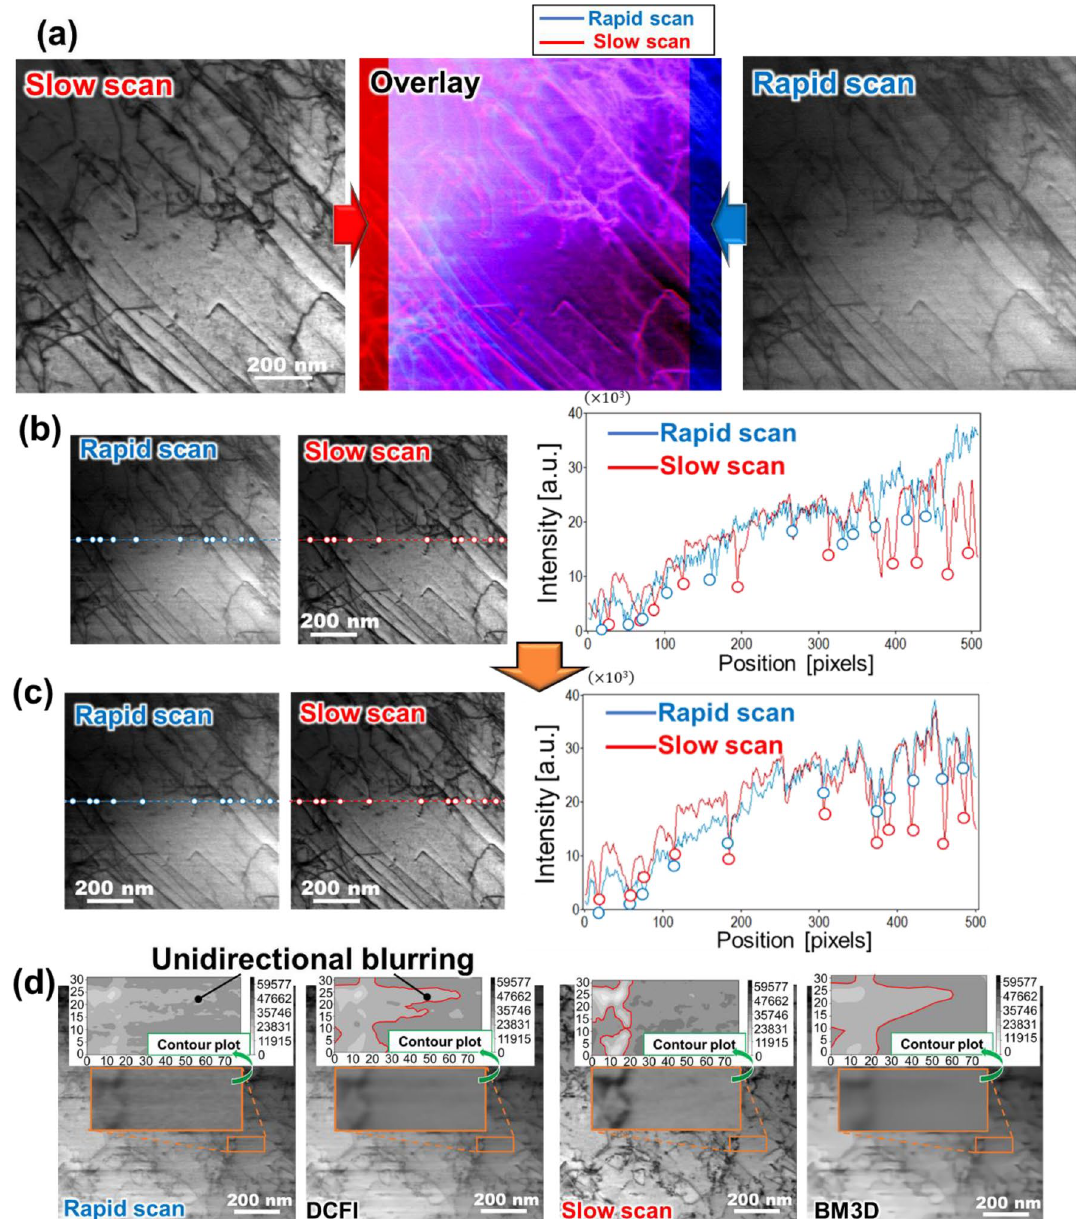
Figure 1. STEM images obtained by different acquisition speed and those properties. Rapid scan of 100 ns/ pixel causes image distortion as clearly represented by ( a ) superposition with STEM image acquired by slow scan of 5 µ s/pixel. The distortion is to be corrected by the way described in "Method" section. Line profiles ( b ) before and ( c ) after distortion correction show the discrepancy at dips representing dislocations is modified by the distortion correction. ( d ) The rapid scanning brings about poor electron signals and delay of detector response, causing statistical noise and unidirectional image blurring, respectively. Although the drift-corrected- frame-integration (DCFI), which is made by averaging 50 frames of rapid scan images, reduces the statistical noise, thus it shows rather smooth contour plot, the blurring remains. The blurring also remains even if the image is processed by well-known noise filter, block-matching-and-three-dimensional (BM3D) 31 , while the slow scan image contains no blurring. Note that the FOV shown in ( d ) were distortion corrected images and not used during training